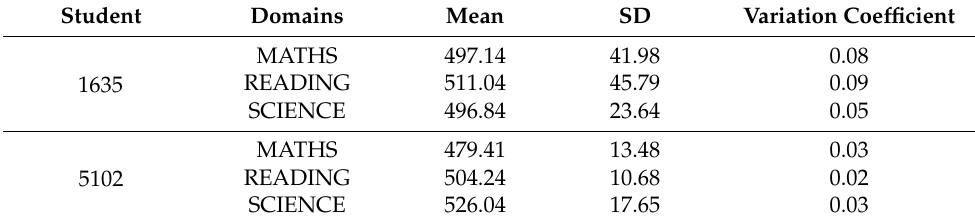
Table 1. Statistics of fuzzy variables for two randomly selected students.